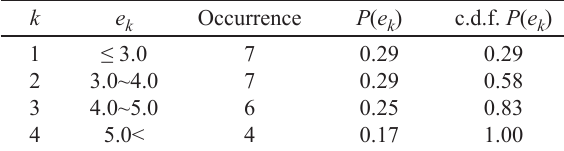
Table 3. Event space e k and probability of e k , P ( e k )